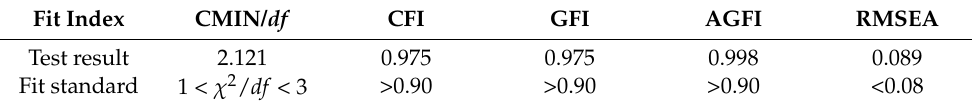
Table 4. Bootstrap analysis of the mediating effect of communication ability between social media use and social anxiety. Path